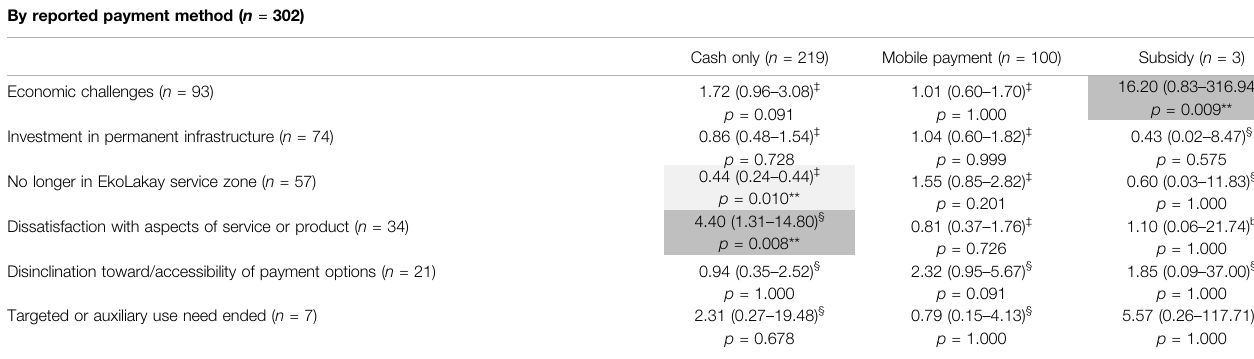
Within the affordability sub-theme, common explanations included dif fi culty avoiding debt in the service ( n (cid:1) 37, 12.3%) or affording the cost ( n (cid:1) 35, 11.6%). Some respondents